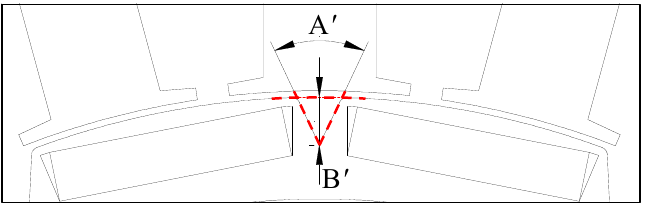
Figure 3. Analysis model for verifying the relationship between the square of the flux variation and eddy current loss in the PM.